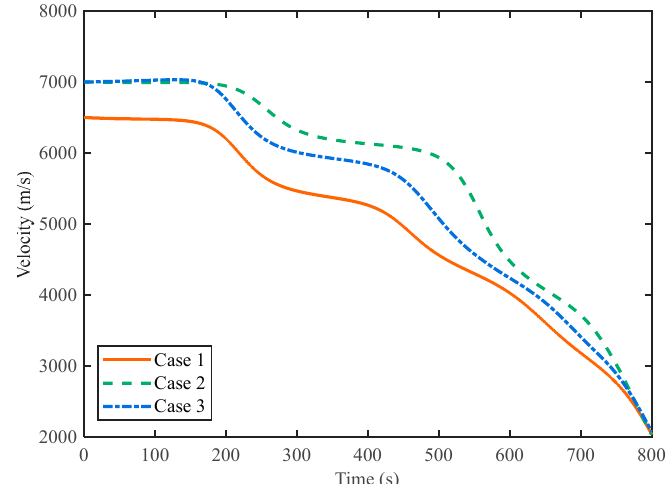
Figure 24. Time histories of the velocity.